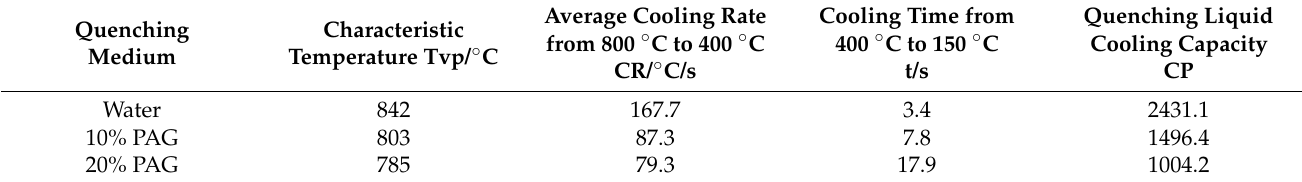
Table 4. The CP of different quenching mediums at 20 °C.